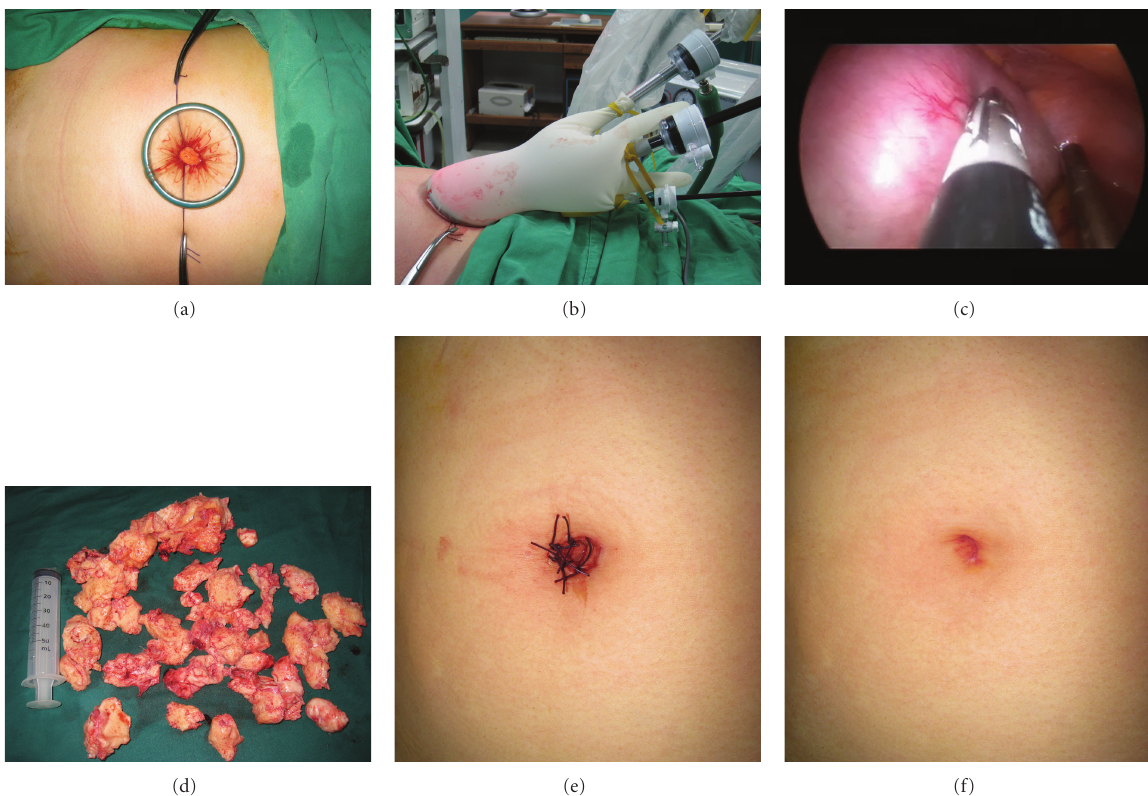
Figure 1: SPA-LAVH for adenomyosis with coexisting myoma (46-year-old woman). (a) Transumbilical single route for surgery using Alexis wound retractor. Distal ring was loaded within the intraperitoneal space and tightly turned inside out of the proximal ring, creating an e ff ective seal and a wider opening of the single-port incision by connecting retractable sleeve between the distal and proximal rings. The fascial edges were tagged with suture for traction prior to port system installation; this was useful for fascial closure at the end of the procedure. (b) Homemade, three-channel, single-port system using the Alexis wound retractor and a surgical glove. A sterile surgical glove was placed over the proximal ring and fixed tightly, and three trocars were inserted through surgical glove with cut edges of the distal fingertips and tied with an elastic string. Varying the height of the trocar head minimized clashing of the bulkiest portion of the trocar head and the instrumental grip (the external handle) extracorporeally overlapping. (c) Laparoscopic finding: huge uterine leiomyoma with coexisting adenomyosis. The largest dimension of the uterus was 15 cm. (d) Photograph showing an extirpated uterus. The weight of the uterus was 750 g. Compared with 50 mL disposable syringe. (e,f) Photograph showing the postoperative umbilical skin wound (postoperative day 1 and 4